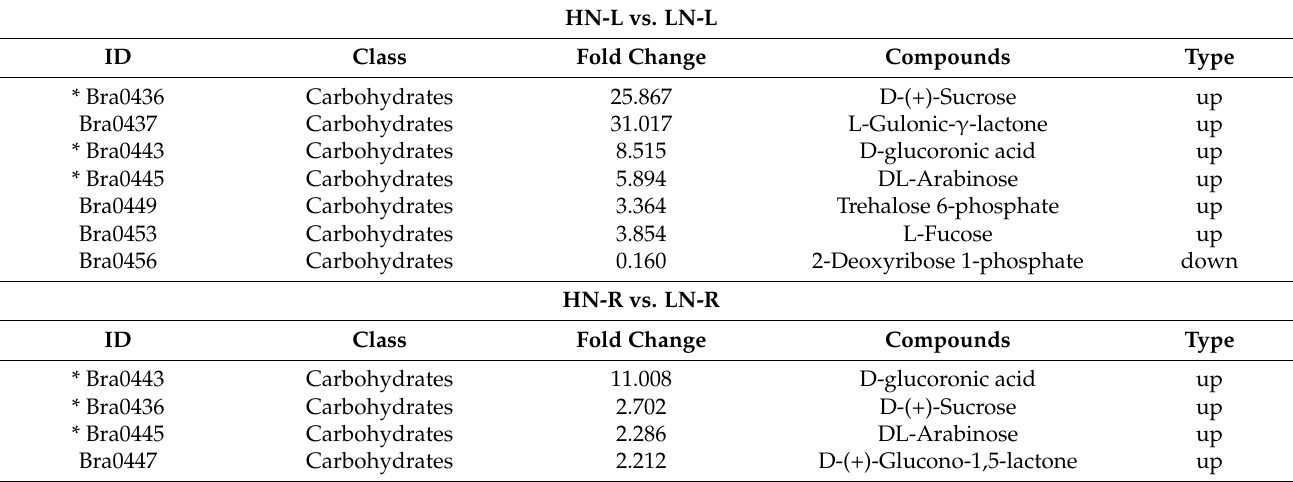
Table 2. Fold change of sugars metabolites detected in the HN leaf when compared to the LN leaf and, HN root compared to the LN root, respectively. Asterisk marks indicate that the metabolite was detected both in the leaf and root.